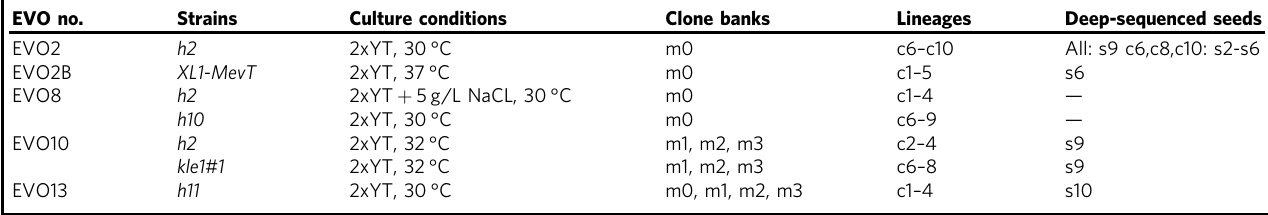
Table 3 Experimentally simulated long-term fermentations EVO